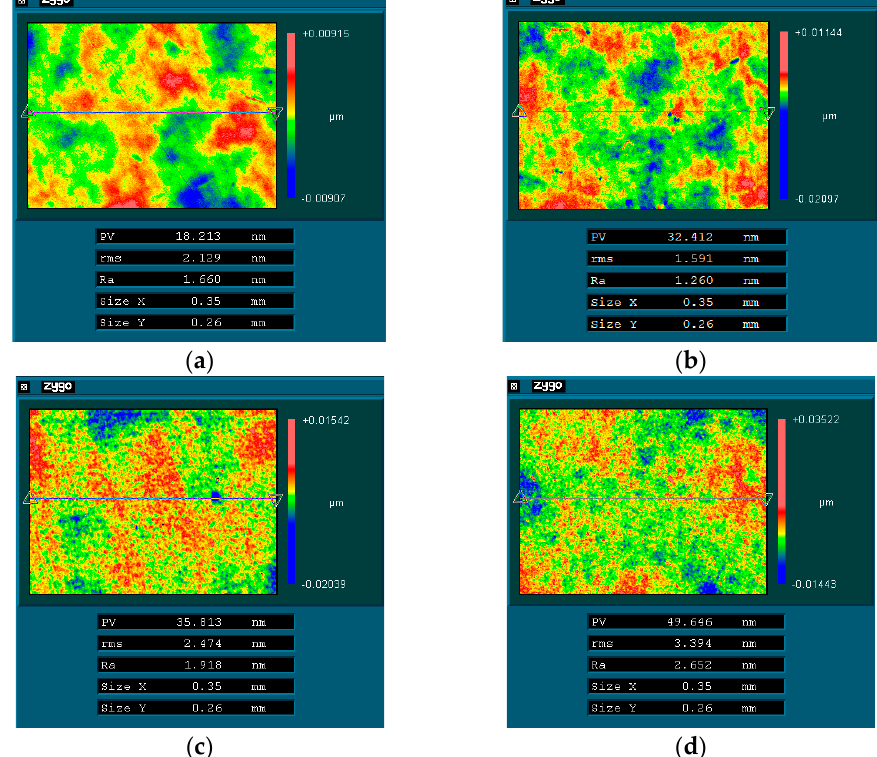
Figure 9. Surface roughness of KDP crystal after polishing with different water contents of polishing fluid: ( a ) 5 wt.%, ( b ) 7.5 wt.%, ( c ) 10 wt.%, and ( d ) 15 wt.%.